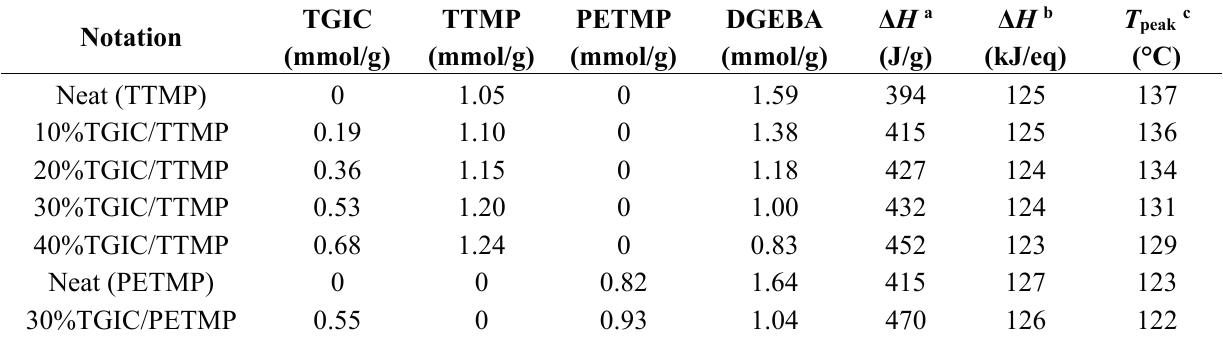
Table 1. Notation, composition and calorimetric data for the mixtures